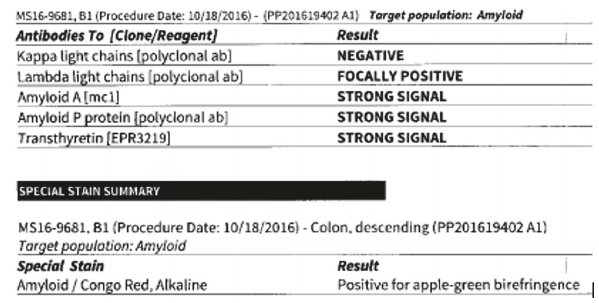
Figure 6: Pathology result of colonic biopsy confirming diagnosis of gastrointestinal